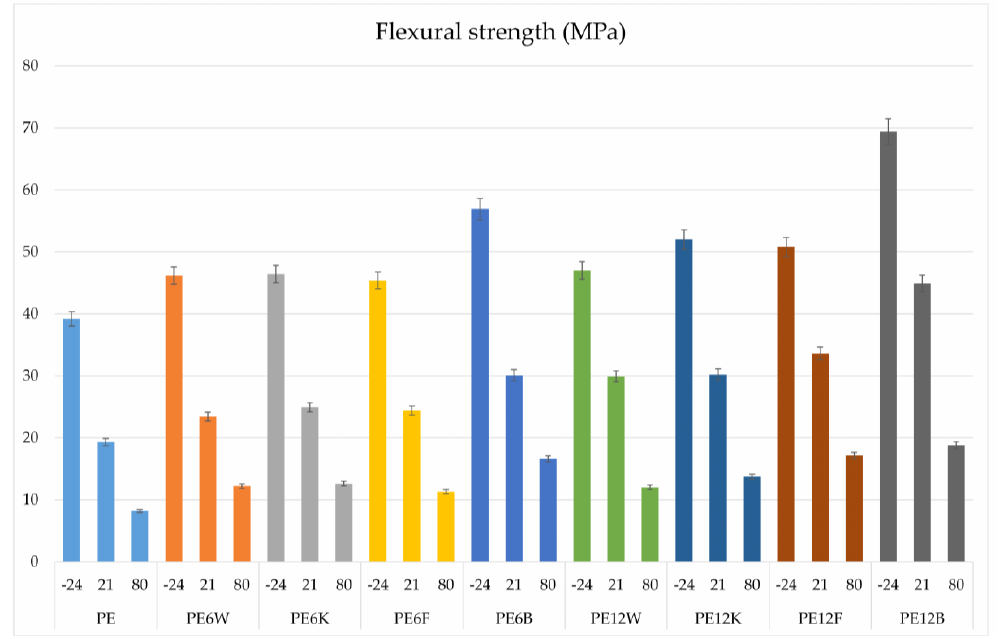
Figure 4. Comparison of flexural strength of tested material.